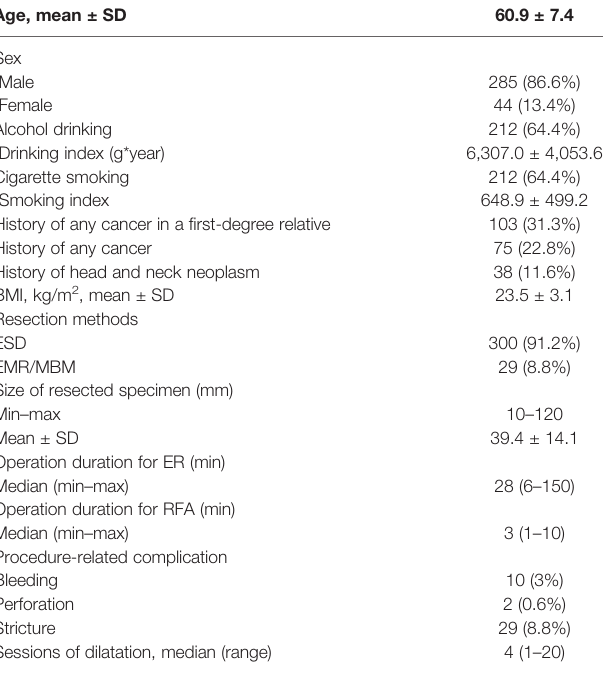
BMI, body mass index; ESD, endoscopic submucosal dissection; EMR, endoscopic mucosal resection; MBM, multiband mucosectomy; Min, minimum; Max, maximum; ER, endoscopic resection; RFA, radiofrequency